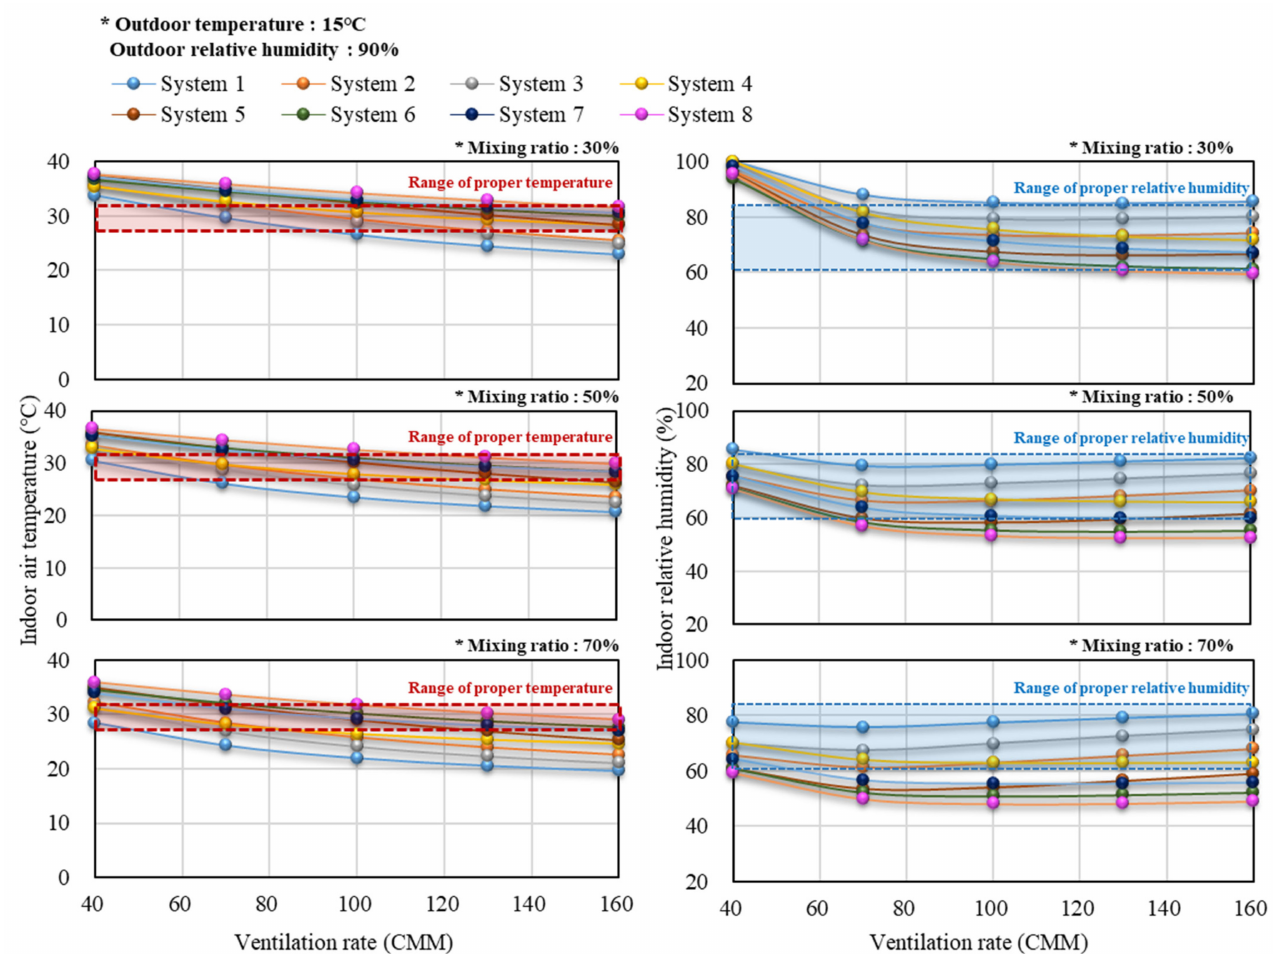
Figure 9. The air temperature and relative humidity inside the experimental piglet room by ARVS according to the ventilation rate and the external air mixing ratio (external air temperature 15 ◦ C, external air relative humidity